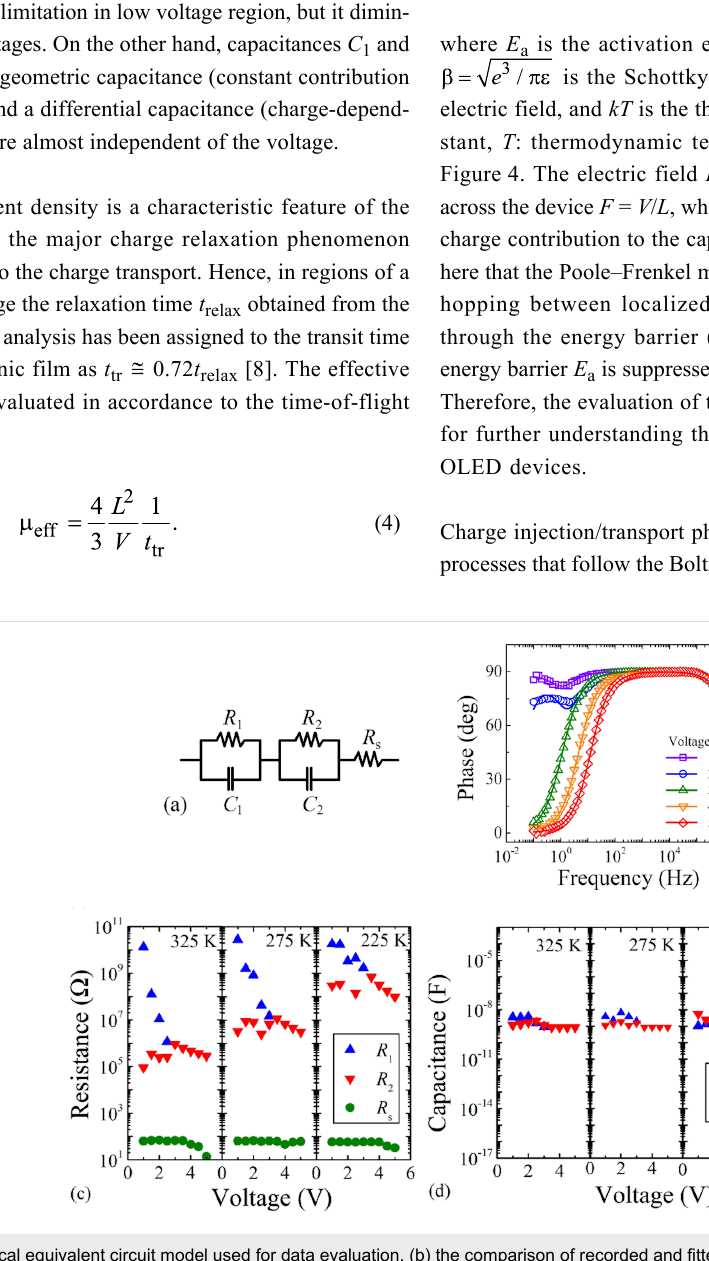
Figure 3: (a) Electrical equivalent circuit model used for data evaluation, (b) the comparison of recorded and fitted impedance phase spectra at temperature 250 K. Symbols represent the experiment, solid line show the equivalent circuit model evaluation. Obtained values of (c) resistances and (d) capacitances of equivalent electrical